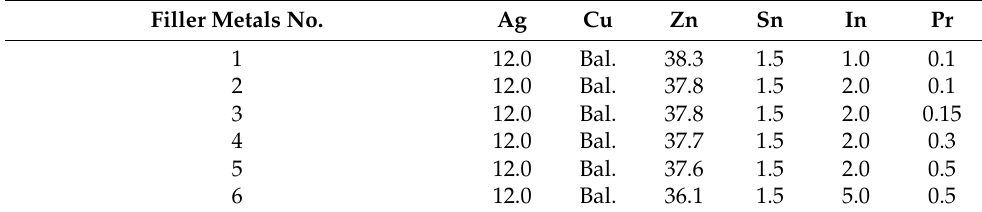
Table 1. Designed composition of the novel filler metals (wt.%). Filler Metals